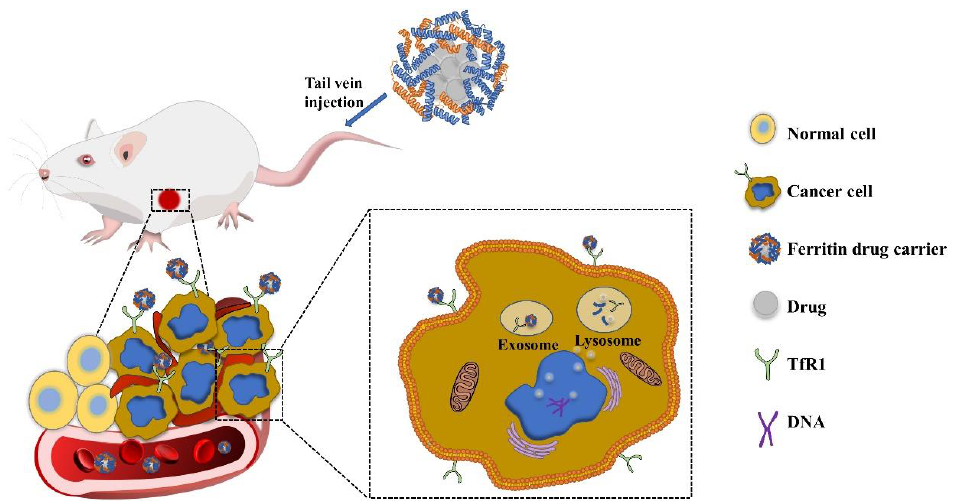
Figure 2. Delivery and release of ferritin drug carrier in vivo.